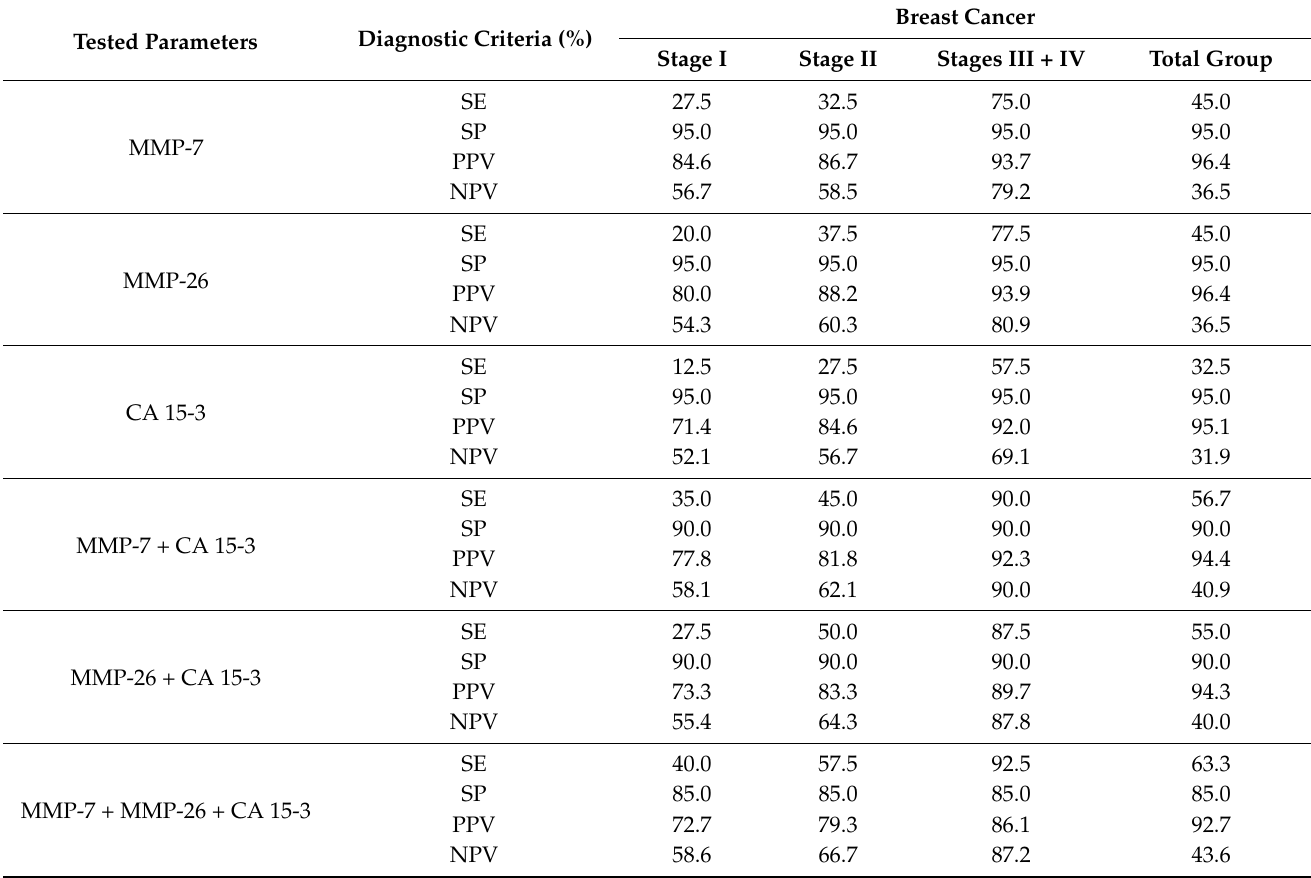
Table 2. Diagnostic criteria of tested parameters in patients with